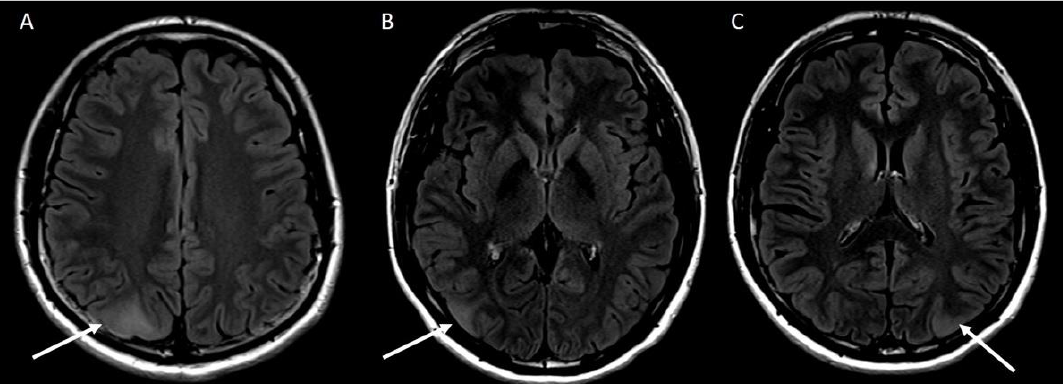
Figure 2. ( A ) T2/FLAIR hyperintensity with associated focal cortical thickening in the right parietal lobe measuring 25 × 18 mm. ( B ) T2/FLAIR hyperintensity at the right parieto-occipital junction measuring 19 × 10 mm. ( C ) T2/FLAIR hyperintensity at the left parieto-occipital junction measuring 14 × 10 mm.